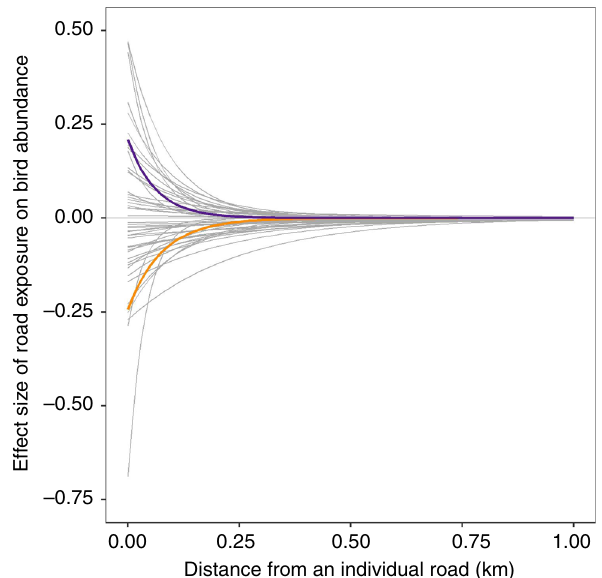
Fig. 3 Effect curves for each species with distance from an individual road. The intercept is determined by the coef fi cient and the rate of decline is determined by the parameter ‘ k ’ , which de fi nes the spatial scale of the relationship between distance from road and road exposure for each species. Only species with strongly signi fi cant associations (determined with Bonferroni correction) between road exposure and bird abundance are featured here. The effect curves for Eurasian bull fi nch and meadow pipit are highlighted in purple and orange, respectively.